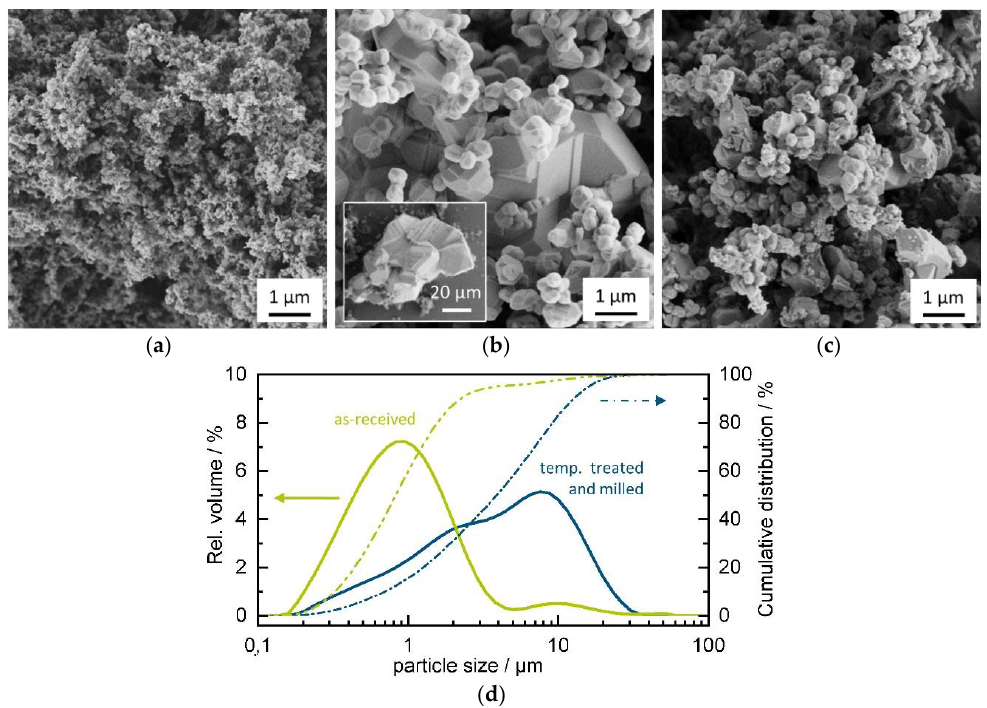
Figure 2. ( a ) SnO 2 powder as-received, ( b ) powder after temperature treatment at 1250 °C in air , ( c ) temperature-treated powder after ball milling, and ( d ) particle size distribution for as-received and fully treated powders (solid lines show the relative volume, dotted lines the cumulative distribution).